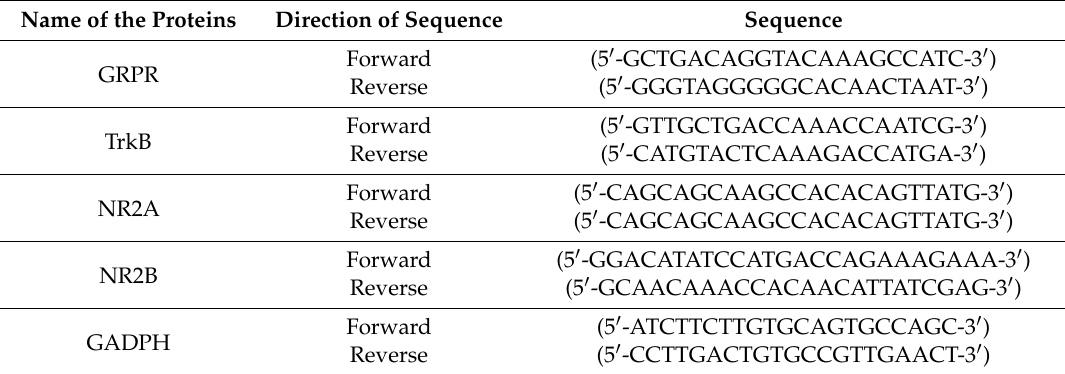
Table 2. Primer’s